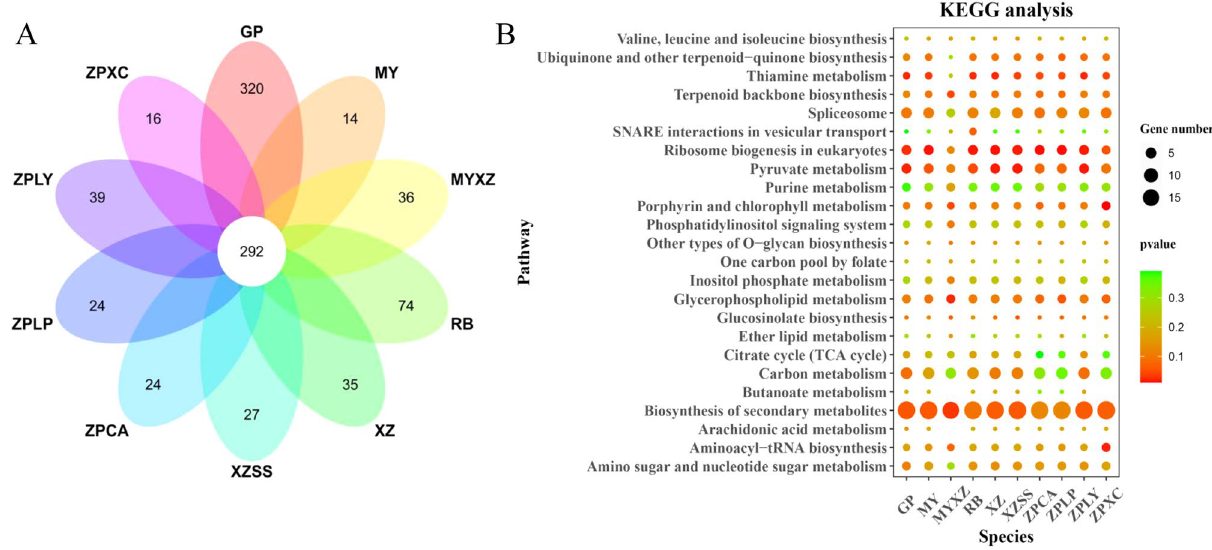
Figure 7. Venn diagram and KEGG analysis for common single copy genes in 10 germplasms of Chaenomeles containing SSR sites. In graph B, the dot size indicates the number of enriched gene; the degree of significance decreases from red to green.Venn diagram was visualized on https:// www. omics hare. com/ tools/. KEGG result was visulized by R3.6.1.